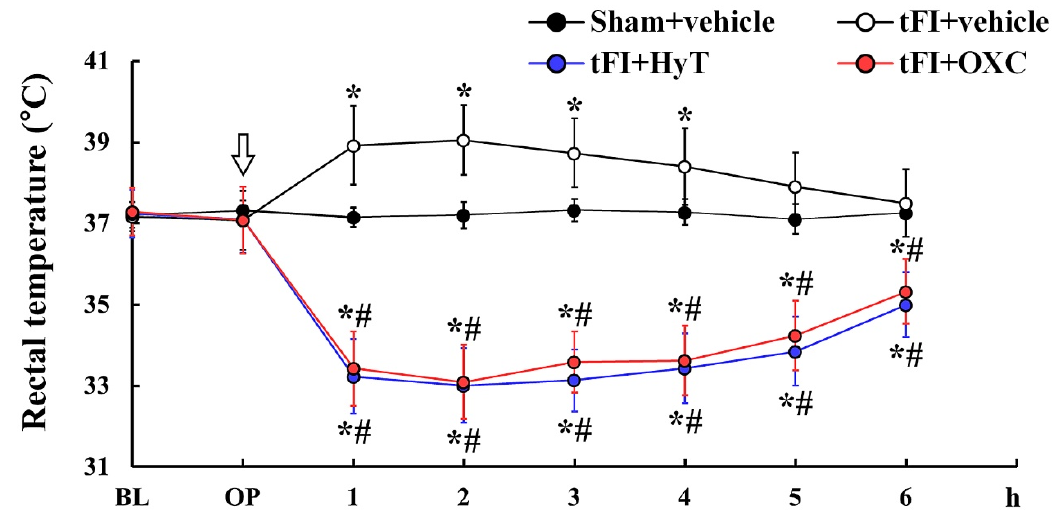
Figure 1. Changes in body temperature for six hours after tFI or sham operation. Body temperature was significantly low in the tFI+HyT and tFI+OXC groups when compared with that in the tFI+vehicle group. The white arrow indicates the time of hypothermia induction and OXC treatment. The bars indicate the means ± SEM ( n = 7 for each group; * p < 0.05 vs. sham+vehicle group, # p < 0.05 vs. corresponding time of tFI+vehicle group). BL, base line; OP, operation (sham or to induce tFI).